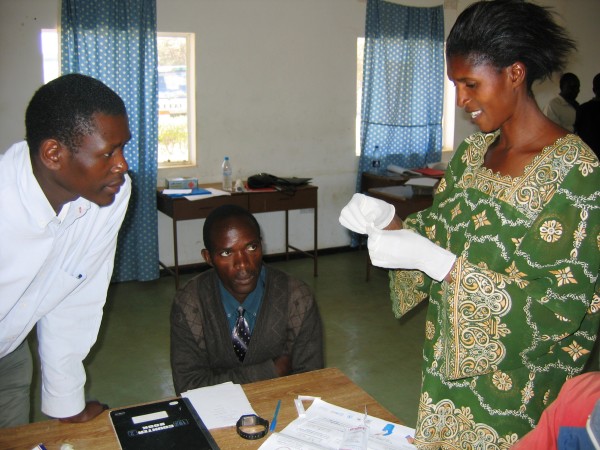
CHW training in RDT preparation. As an observer (left) and another CHW (center) watch, a Zambian CHW prepares to open a blood lancet during training on RDT use.